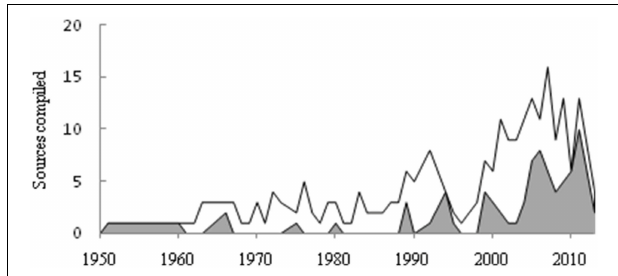
FIGURE 2 | Number of studies on fish reproduction for Brazilian marine fishes. Language in which the studies were published: English (gray) or Portuguese (white).